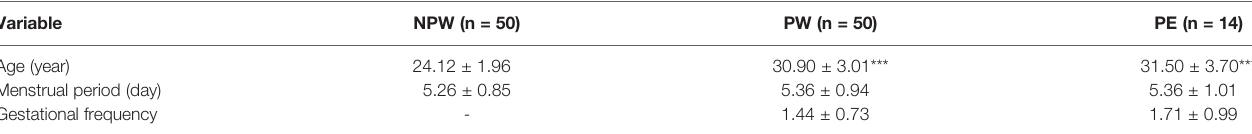
TABLE 1 | Clinical characteristics of